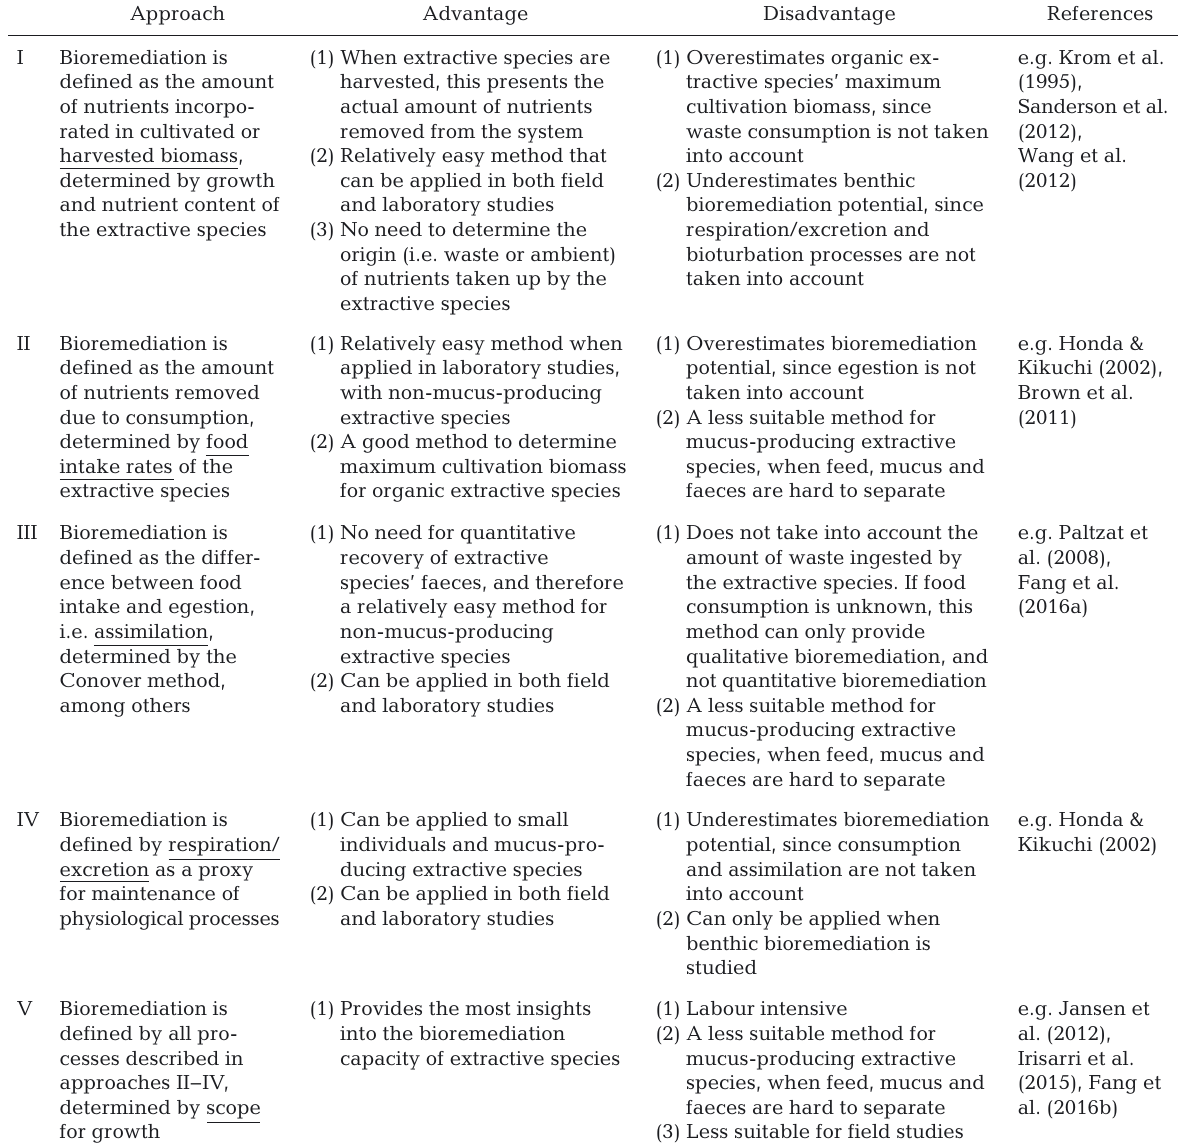
Table 4. Overview of approaches applied in integrated multi-trophic aquaculture (IMTA) studies to define bioremediation potential of extractive species